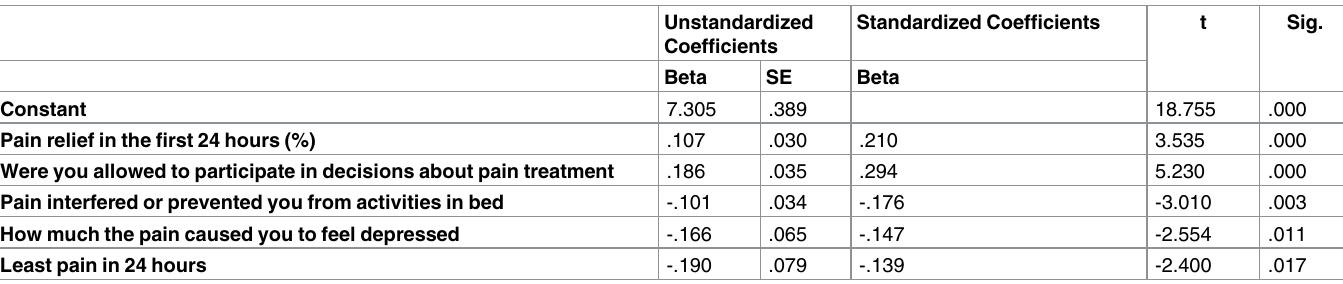
Table 6. Regression model of satisfaction